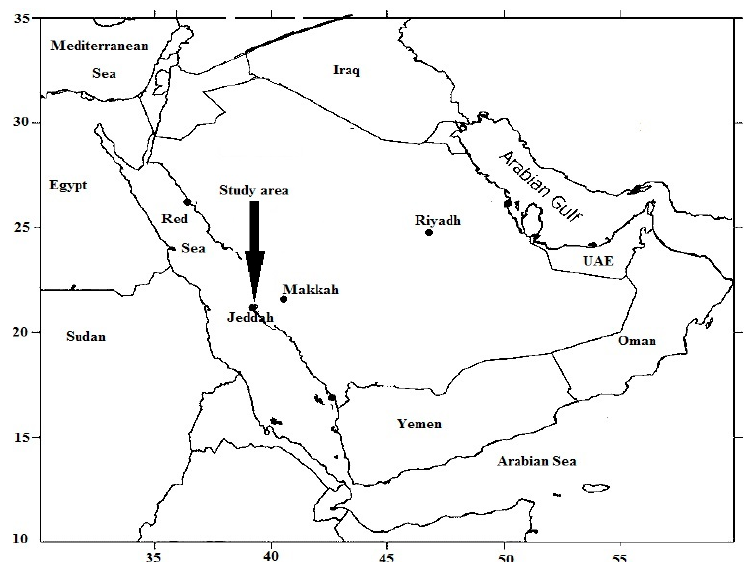
Figure 1. Map showing the study site location.